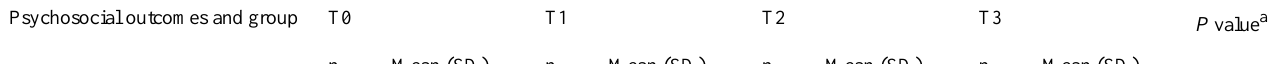
Table 4. Descriptive statistics and results of the linear mixed models on personal adjustment (Communication Profile for the Hearing Impaired) and emotional response (Hearing Handicap and Disability Inventory; secondary